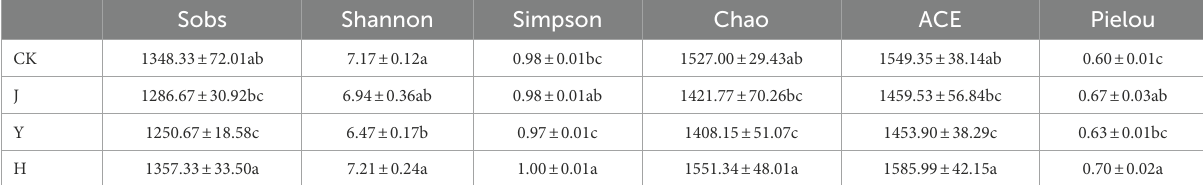
TABLE 12 Bacterial community diversity indices in soybean-potted root. Sobs